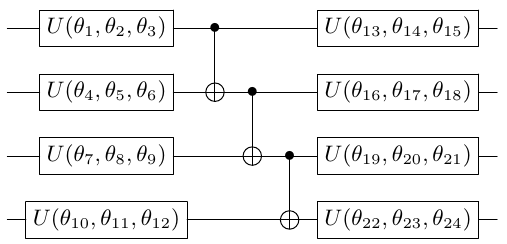
FIG. 4. Four-qubit heuristic circuit ansatz for LiH in the VQE